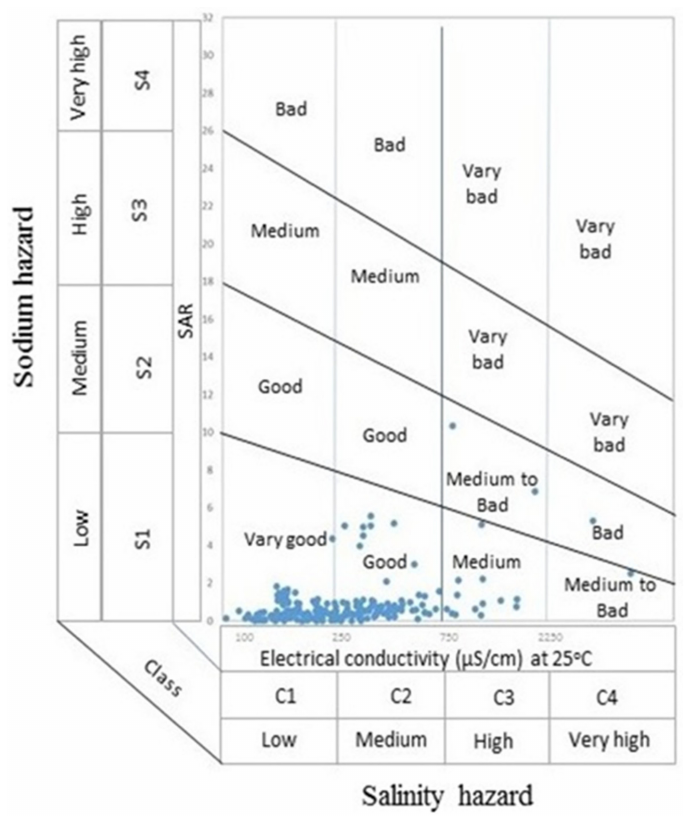
Figure 16. USSL diagram of water